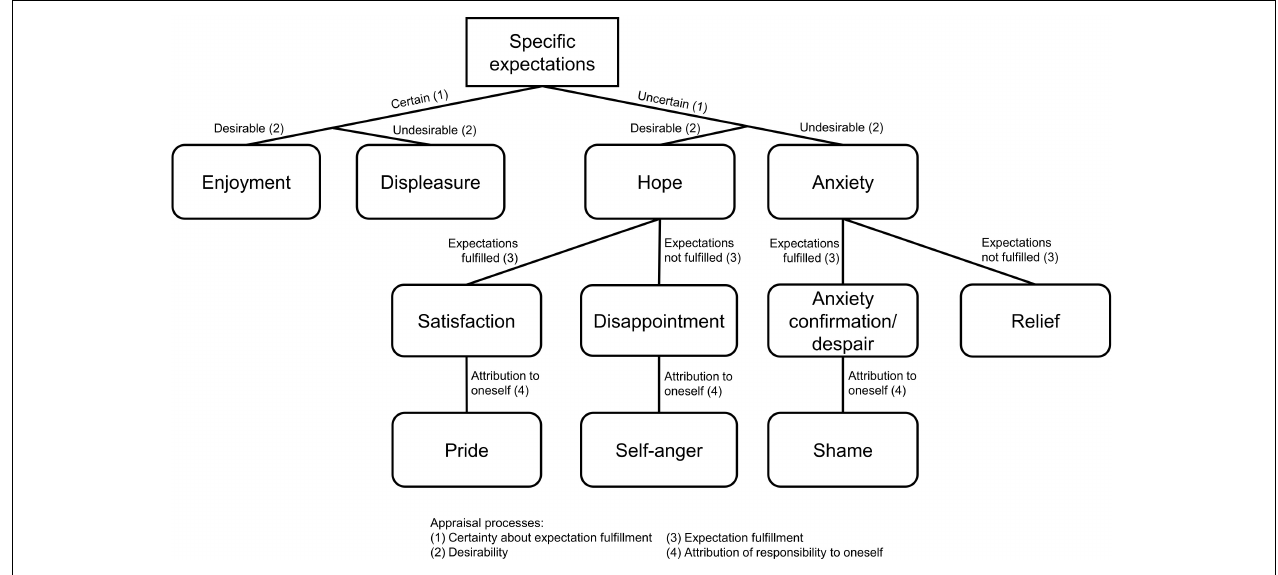
FIGURE 1 | Theoretical model of anticipated emotion categories in exercise